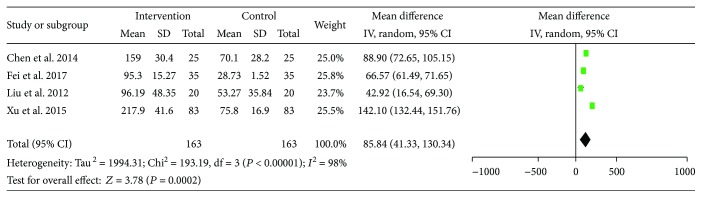
Forest plot for PAB.